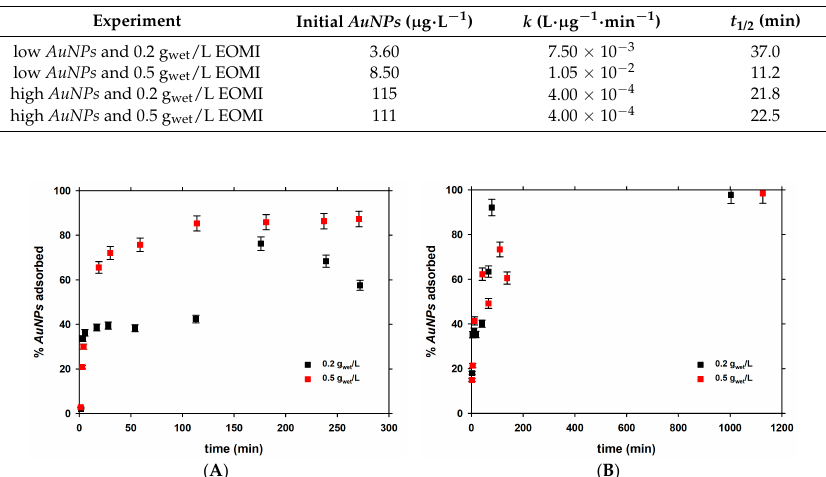
Figure 1. Short-term adsorption kinetics of AuNPs onto 0.2 and 0.5 g wet /L of diatoms EOMI, at two initial AuNPs concentrations (3.6–8.5 µg AuNPs /L ( A ) and 111–115 µg AuNPs /L ( B )) under darkness at pH of 6.4 ± 0.1. The error bars are within the symbol size unless shown. They correspond to standard deviation of duplicates.